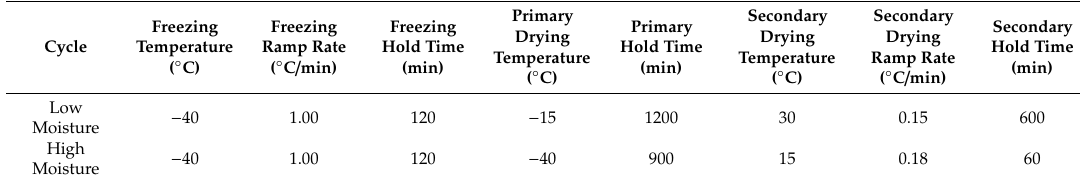
Table 1. Freeze drying cycle for IgG